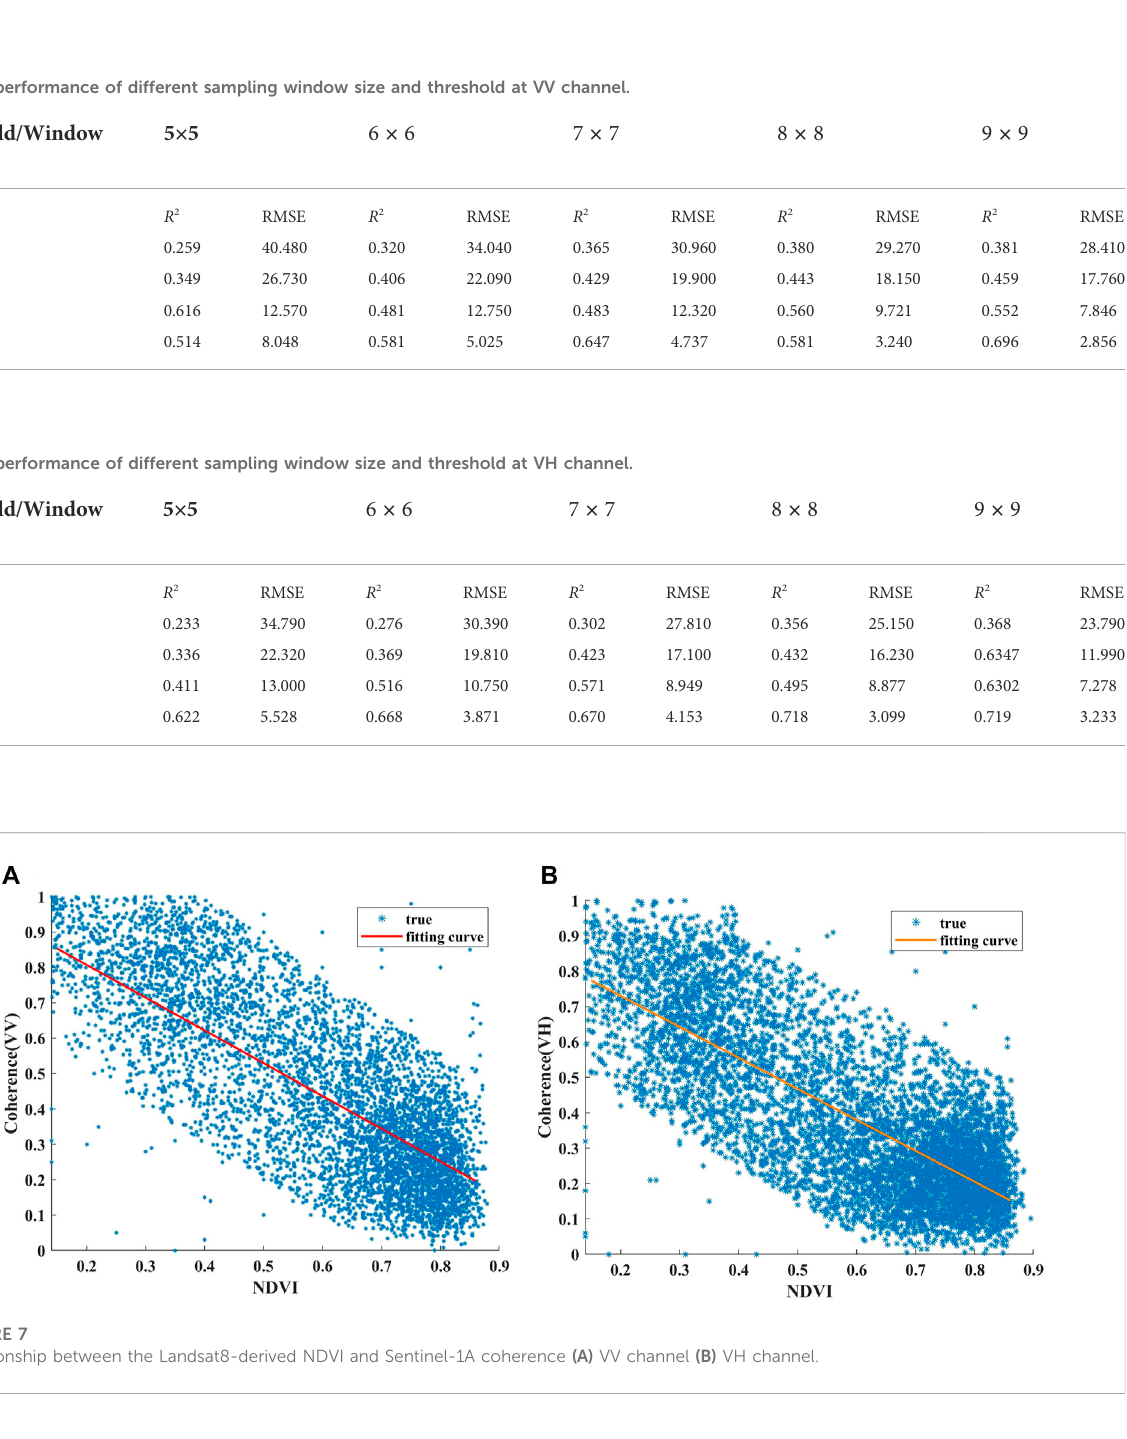
the mean error in VV-polarization is -0.067 with a standard deviation of 0.256, most of the errors distribute between − 0.4 and 0.4 and basically obey a normal distribution. As shown in Figure 11B, the mean error in VH-polarization is − 0.065 with a standard deviation of 0.230, these errors are larger and more discrete than those in the study area on the whole, but still roughly obey a normal